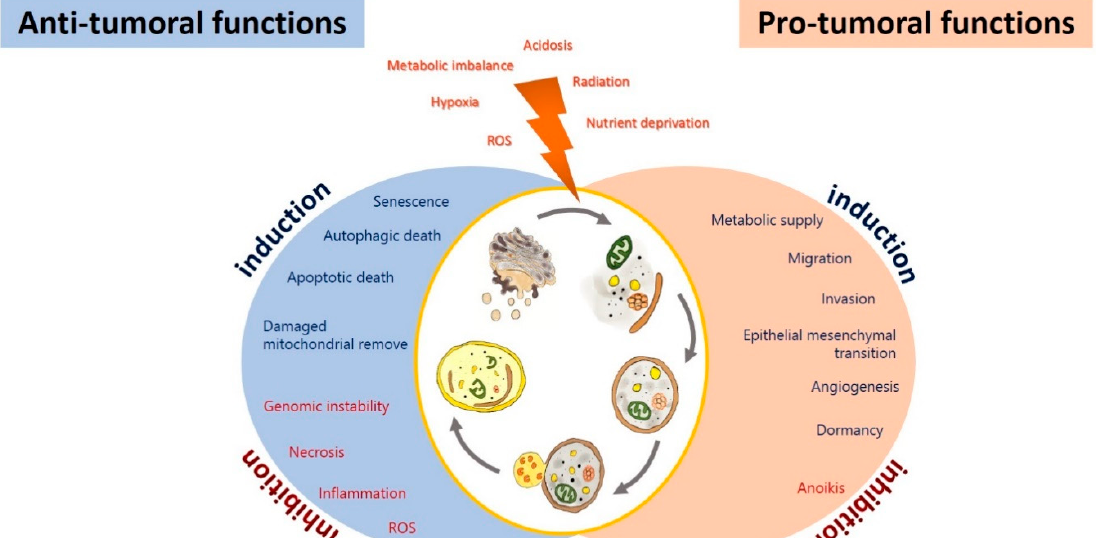
Figure 2. Anti-tumoral and pro-tumoral functions of autophagy. As an anti-tumoral process, autophagy prevents the accumulation of p62 aggregates, damaged proteins, and mitochondria, which may lead to ROS generation and the activation of oncogenic signaling pathways to stimulate necrosis, inflammation, and genomic instability, which lead to malignant transformation, tumor cell proliferation, migration, and invasion. Excessive autophagy can lead to type-II programmed cell death, which can induce apoptosis and activate senescence. On the other hand, autophagy sustains tumor growth and survival under adverse conditions (hypoxia and metabolic, osmotic, and oxidative stress). Uncontrolled proliferation leads to degrading misfolded or unnecessary proteins and organelles to mobilize amino acids, lipids, and carbohydrates, promoting cell survival. It also increases oncogenic signals that favor metabolism (glycolytic functions), angiogenesis, migration, and tumor invasion; additionally, it inhibits anoikis and dormancy.